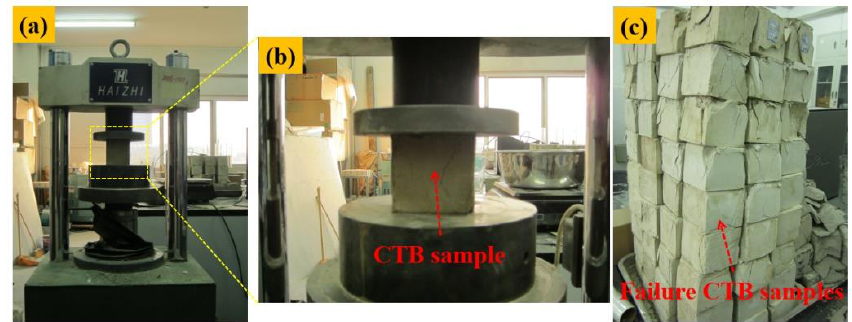
Figure 4. UCS testing: ( a ) testing apparatus; ( b ) cured CTB sample; ( c ) failure CTB samples.